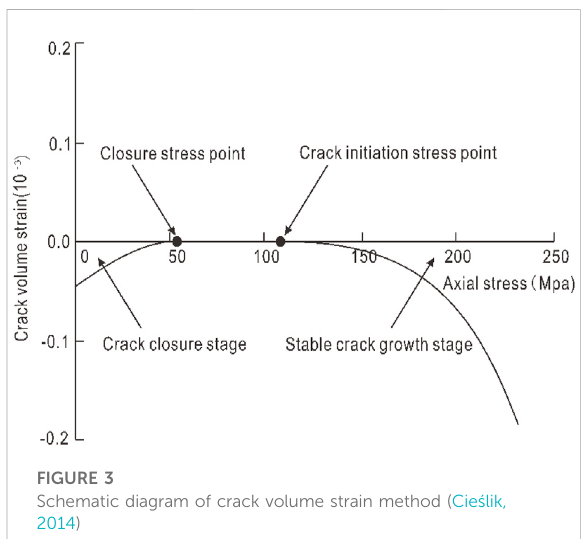
FIGURE 3 Schematic diagram of crack volume strain method (Cie ś lik,